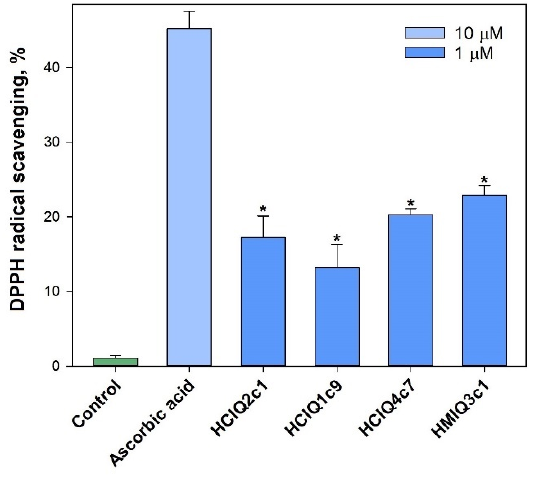
Figure 9. Scavenging activity levels of the peptides against DPPH radicals outside the cells. The data are shown as the mean ± SE; *— p < 0.05.